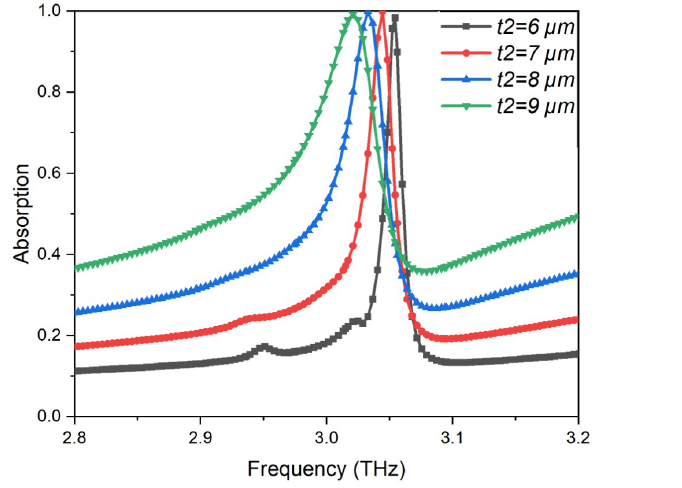
Figure 5. Absorption spectra obtained by varying the height of the substrate.